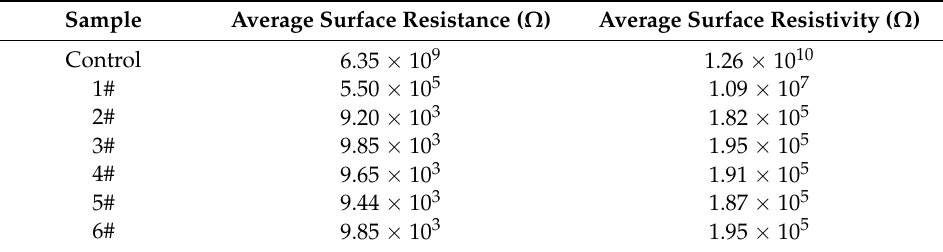
Table 4. Surface resistance of untreated and treated nonwoven polypropylene.